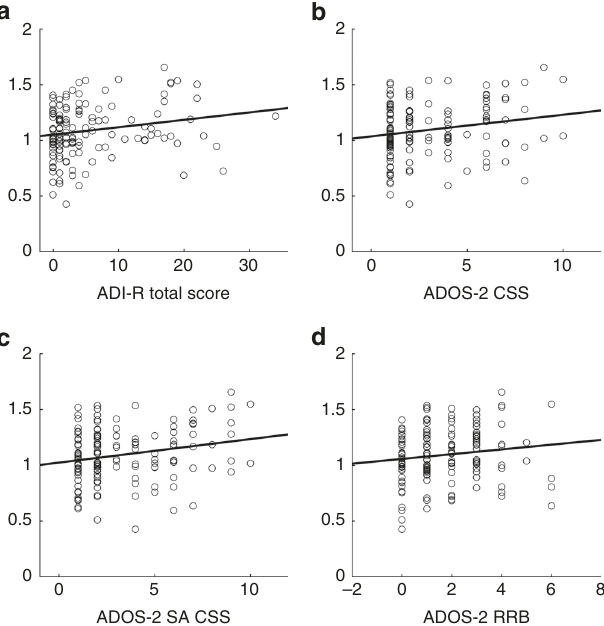
Fig. 2 Scatterplots showing the association between normalized relative constriction of the PLR in infancy and severity measures of ASD symptoms at three years of age. Large relative constriction of the PLR in infancy was associated with having higher a ADI-R scores, b ADOS-2 comparison scores, and c Social affect (SA CS) comparison scores (ADOS-2 subscale). The relation for the Restricted and Repetitive Behaviors (RRB) algorithm scores (ADOS-2 subscale) did not reach statistical signi fi cance ( d ).